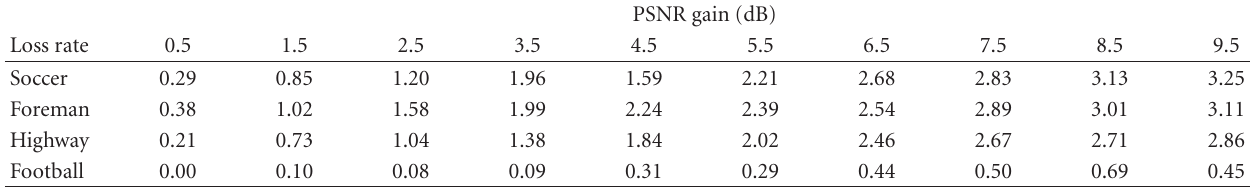
Table 3: Mean Y-PSNR gain when applying the proposed mapping scheme, as compared to assigning the video stream to AC2 for a range of test